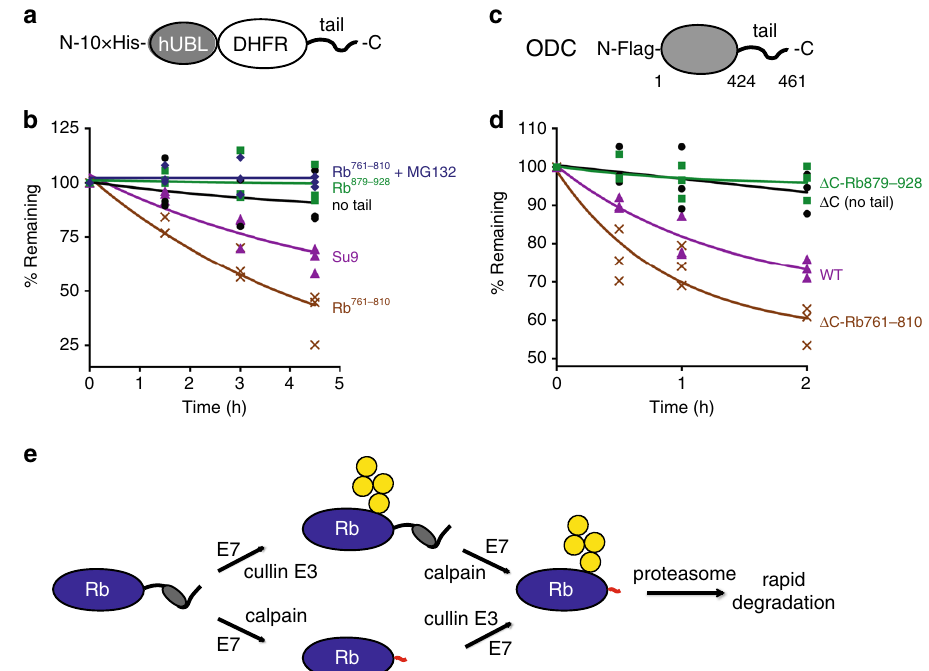
Fig. 4 The unmasked tail of Rb serves as an effective initiation region in vitro. a Sketch of proteasome substrates consisting of the UBL domain of human HR23B with 10×His-tag at the N-terminus, followed by an E. coli DHFR domain and a tail (10×His-hUBL-DHFR-tail). b Degradation of 10×His-hUBL-DHFR- tail containing different C-terminal tails as indicated by puri fi ed mammalian 26S proteasomes. 100 μ M MG132 was added to the reactions where indicated. The graph plots the relative amount of protein estimated by electronic autoradiography in SDS-PAGE gel bands (representative images are shown in Supplementary Fig. 3b) over time as a percentage of the initial protein amount from three repeat experiments. c Schematic representation of Flag-tagged human ODC protein. ODC contains an unstructured region at its C-terminal end. d Degradation of ODC and the indicated variants by puri fi ed mammalian 26S proteasomes as in b : Flag-tagged ODC (WT), Flag-tagged ODC in which the C-terminal tail (amino acids 425 – 461) is deleted ( Δ C (no tail)), Flag- tagged ODC in which amino acids 425 – 461 are replaced with amino acids 879-928 of Rb ( Δ C-Rb 879 – 928 ), and Flag-tagged ODC in which amino acids 425 – 461 are replaced with amino acids 761 – 810 of Rb ( Δ C-Rb 761 – 810 ). Representative gel images are shown in Supplementary Fig. 3d. The graph plots the relative band intensities from three repeat experiments. e Proposed model of E7-mediated destabilization of Rb. E7 induces Rb cleavage and also enhances its ubiquitination, both of which facilitate degradation of Rb by the proteasome. Exposure of the intrinsic disordered region of Rb by calpain cleavage markedly accelerates proteasomal degradation of Rb because the exposed region serves as an effective initiation region for proteasomal degradation. Source data are provided as a Source Data fi